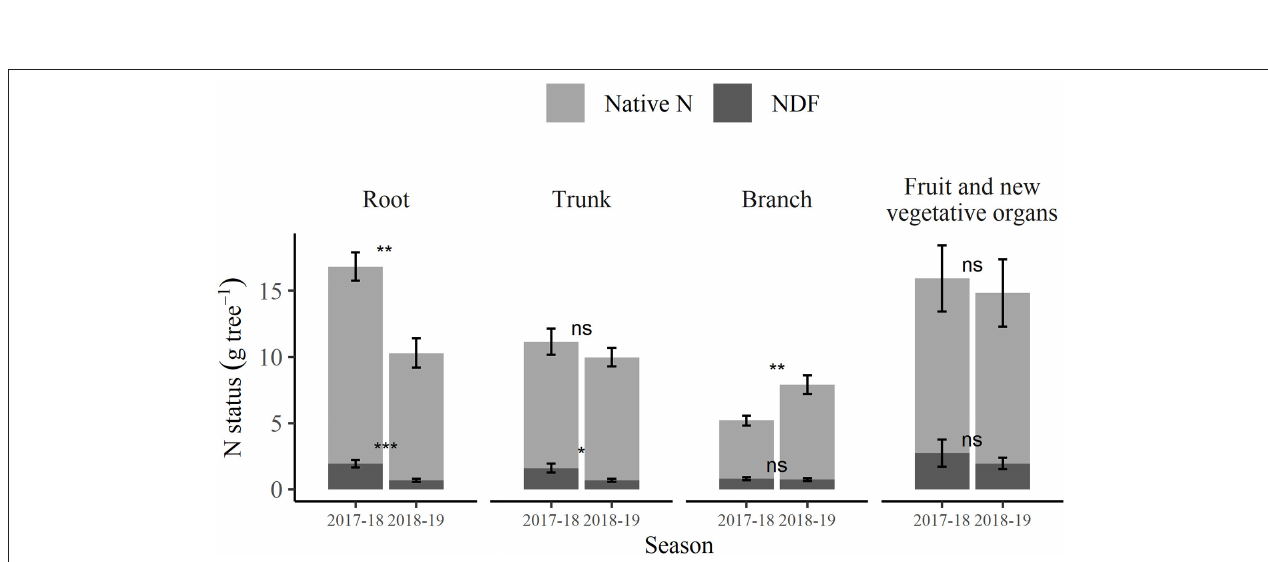
FIGURE 6 | Total N in each organ showing composition of native N and nitrogen derived from fertilizer (NDF) at 1 week after fruit harvest of the 2018–2019 season under different N application treatments. Error bars represent ± SEM, n = 4.